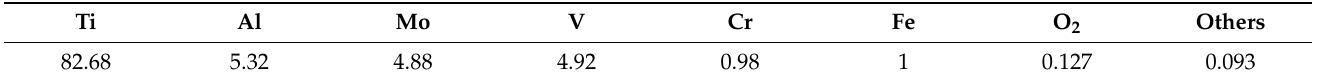
Table 1. Chemical composition of the α + β titanium alloy (wt.%, as per